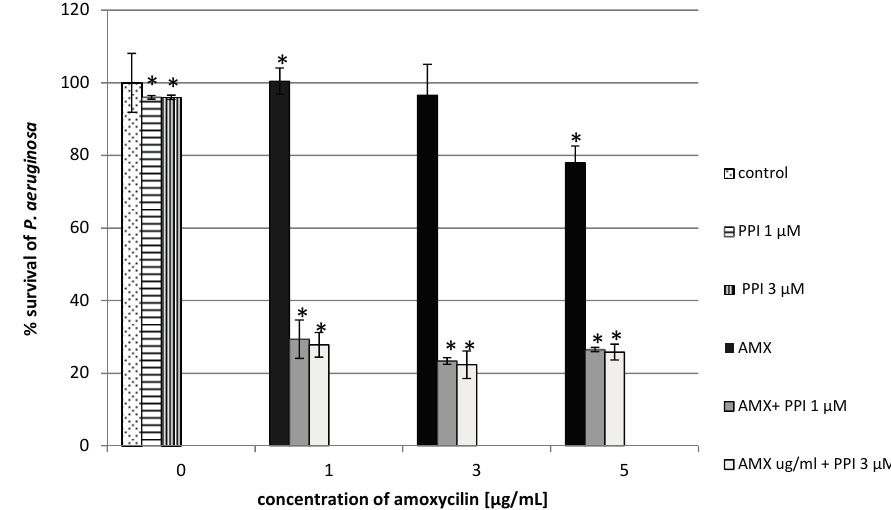
Figure 2. Growth of P. aeruginosa after 24 h incubation with unmodified poly(propylene imine) dendrimers (PPI) or/and amoxicillin (AMX). Each bar represents and the mean and